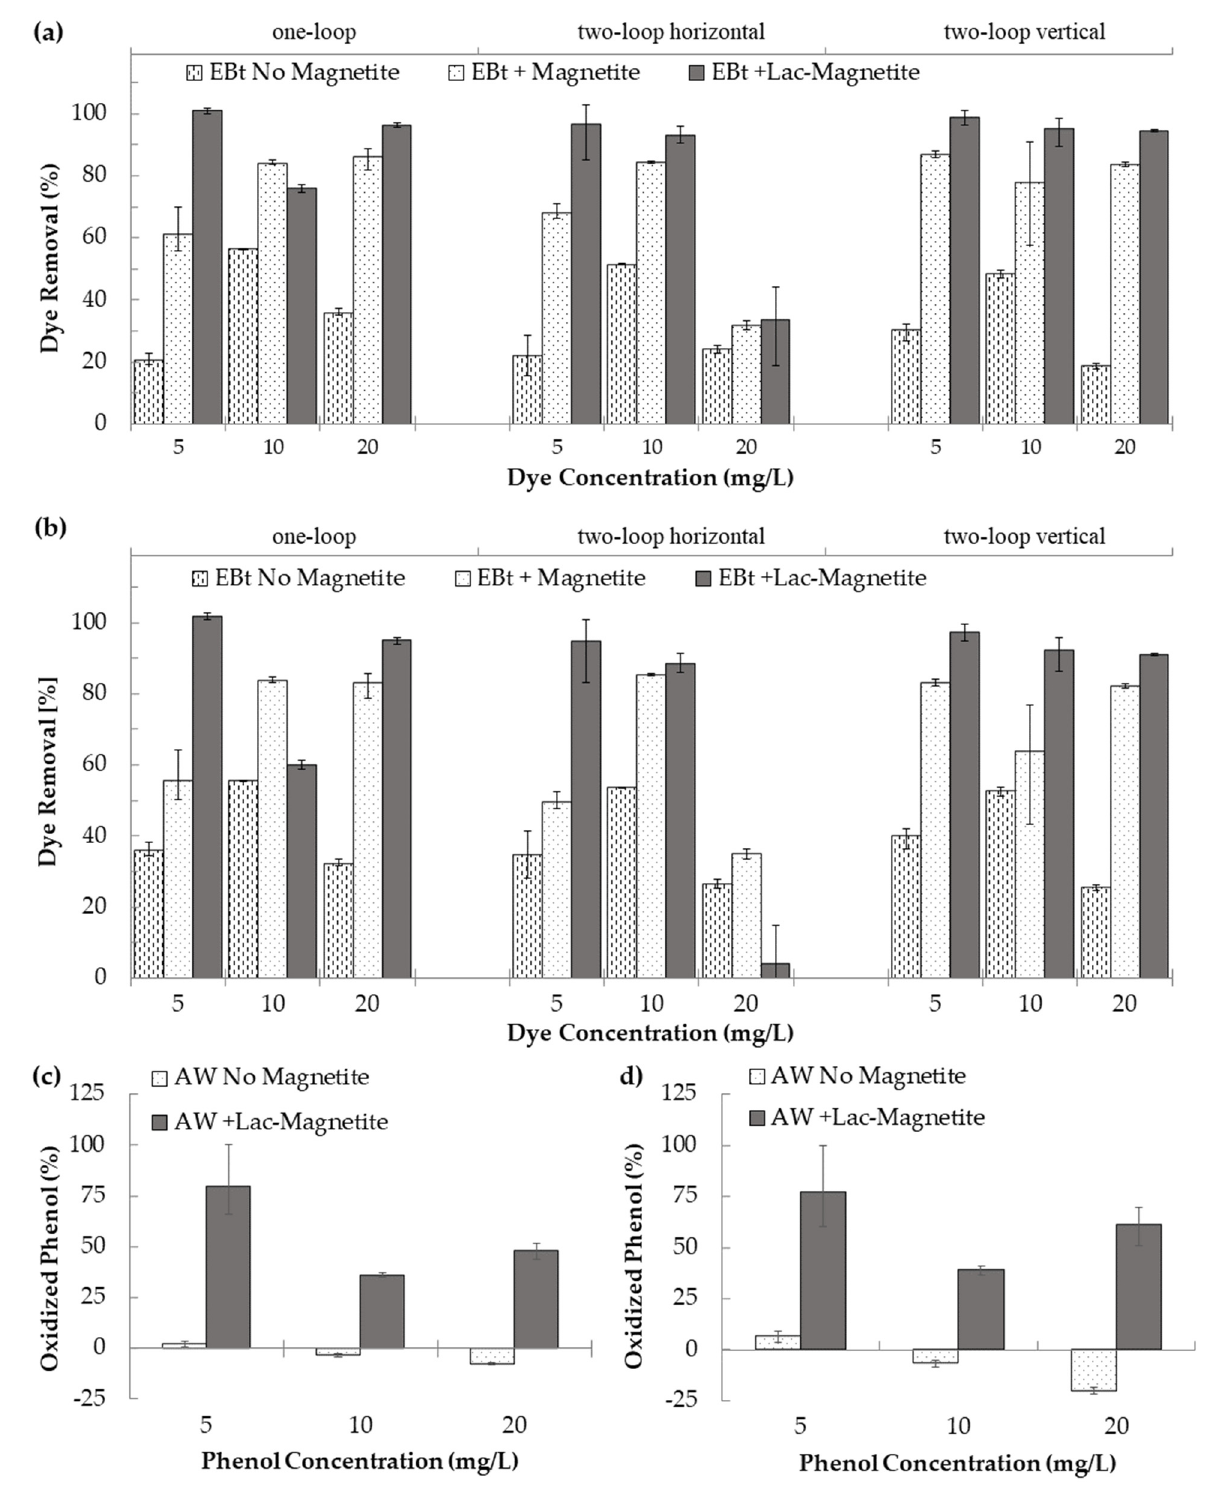
Figure 7. ( a ) Removal of Eriochrome Black T for the three microreactor configurations as estimated by absorbance peak. ( b ) Removal of Eriochrome Black T for the three microreactor configurations as estimated by absorbance area. ( c ) Percentage of oxidized phenol for the two-vertical-loop microreactor as estimated by absorbance peak. ( d ) Percentage of oxidized phenol for the two-vertical-loop microreactor as estimated by absorbance area.